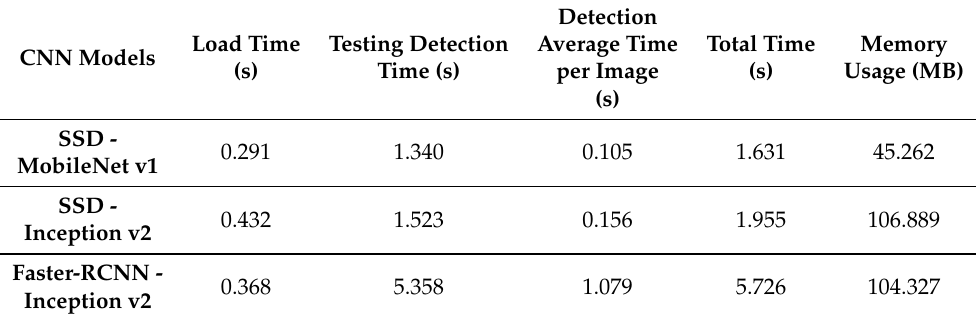
Table 4. Experimental Scenario I, x64 CPU CNN detection time and memory